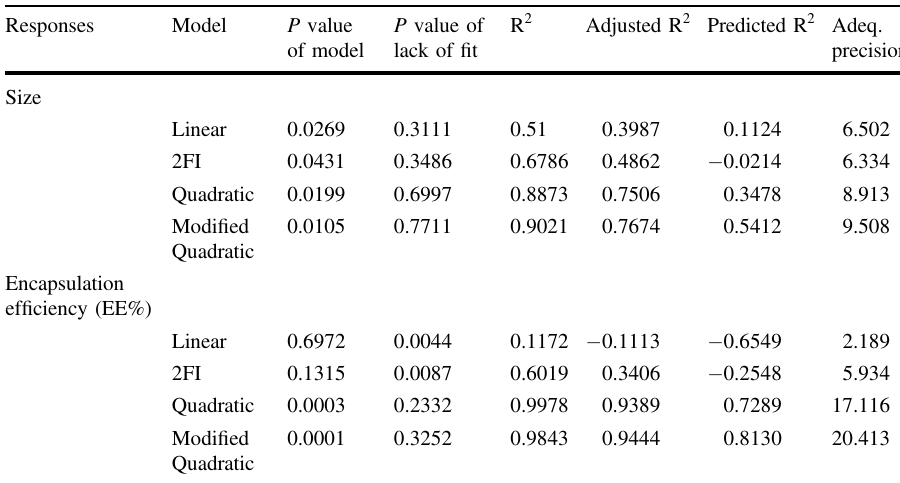
Table 4 Results of regression analysis of responses for size &